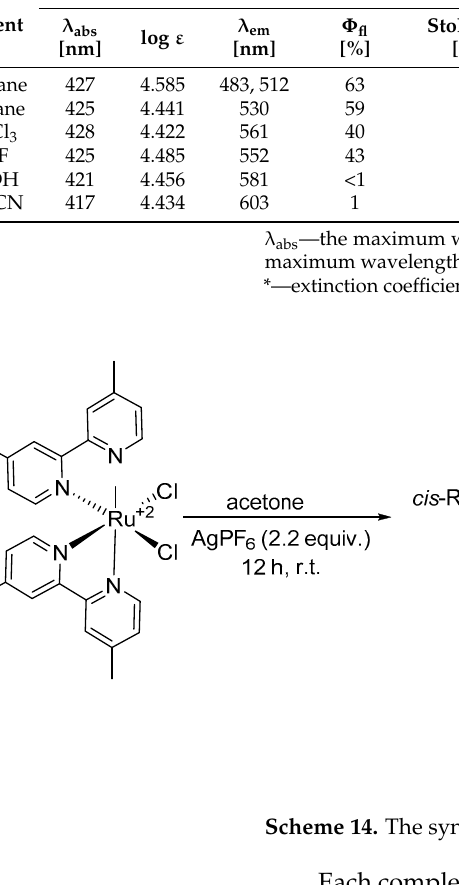
Table 7. Spectroscopic behavior of dyes A2 and D1 in different